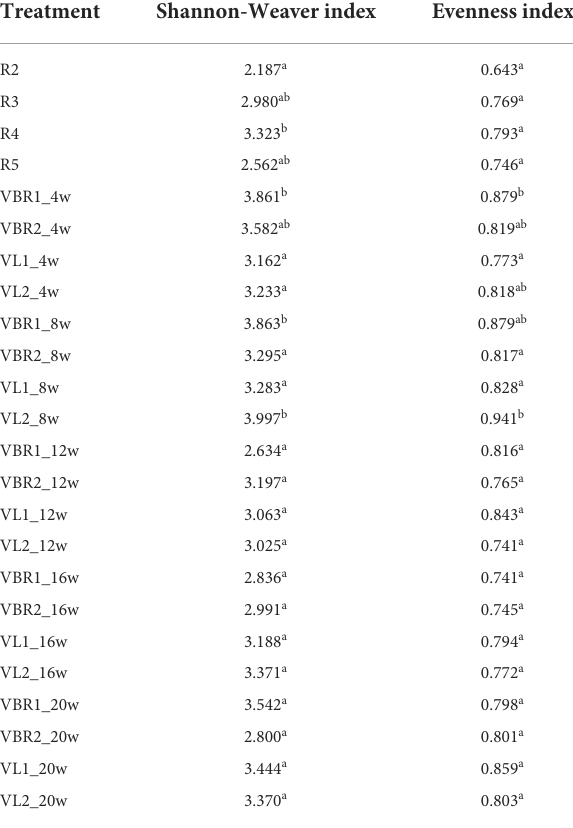
TABLE 2 The Shannon-Weaver diversity index and the Evenness Index between the bambara groundnut landraces and specific sampling